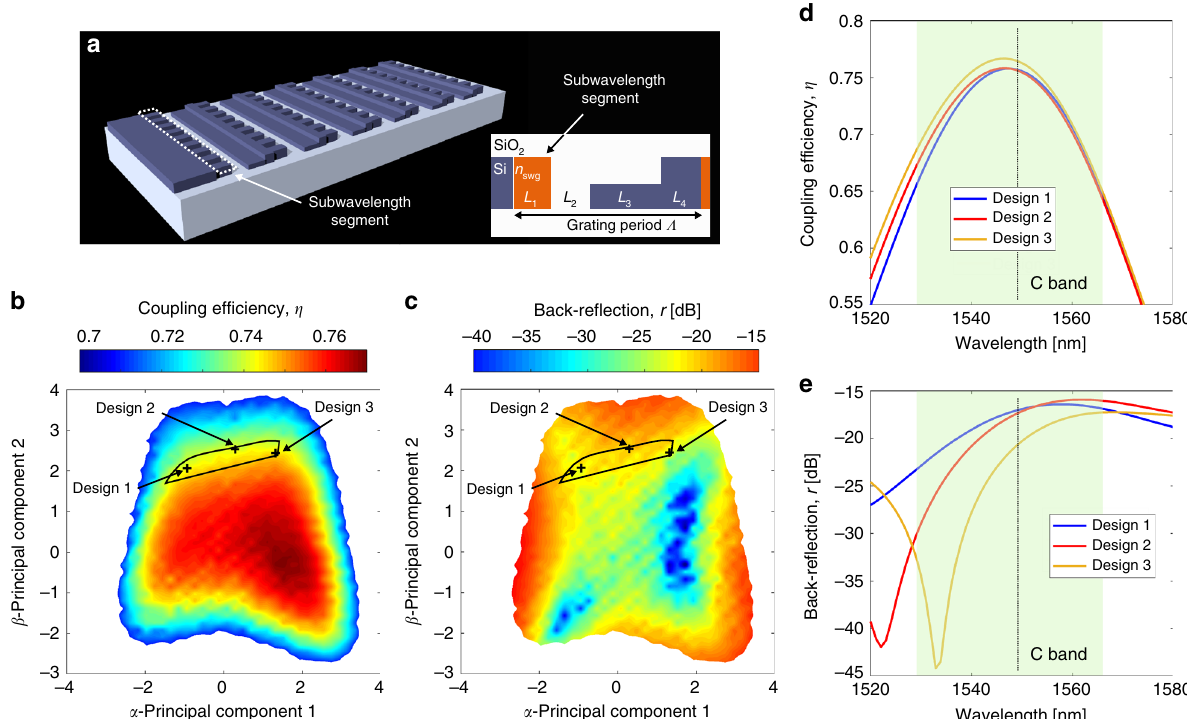
Fig. 5 Vertical grating coupler with subwavelength metamaterial. a Schematic representation of the grating structure, with the subwavelength segment highlighted. The inset shows a 2D cross-section of the grating where the subwavelength metamaterial is modeled by an effective medium. Dimensionality reduction reveals that two principal components are suf fi cient to represent the good designs instead of the original fi ve parameters. Plotted in b and c are the corresponding exhaustive maps of coupling ef fi ciency and back re fl ection over the reduced parameters sub-space, respectively. Only designs with η > 0.7 are shown. The black contour encloses the design region that ensures η > 0.74 (as in Fig. 3) and also a minimum feature size greater than 100 nm in both the propagation and transverse directions. These solutions were not possible with the grating structure shown in Fig. 2. d , e 2D-FDTD simulations